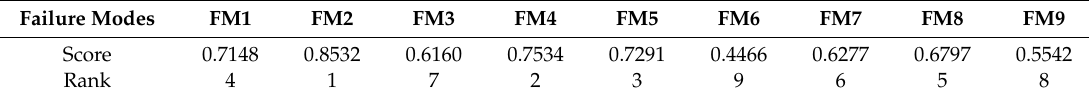
Table 10. Performance score and rank of each failure mode for p = q =